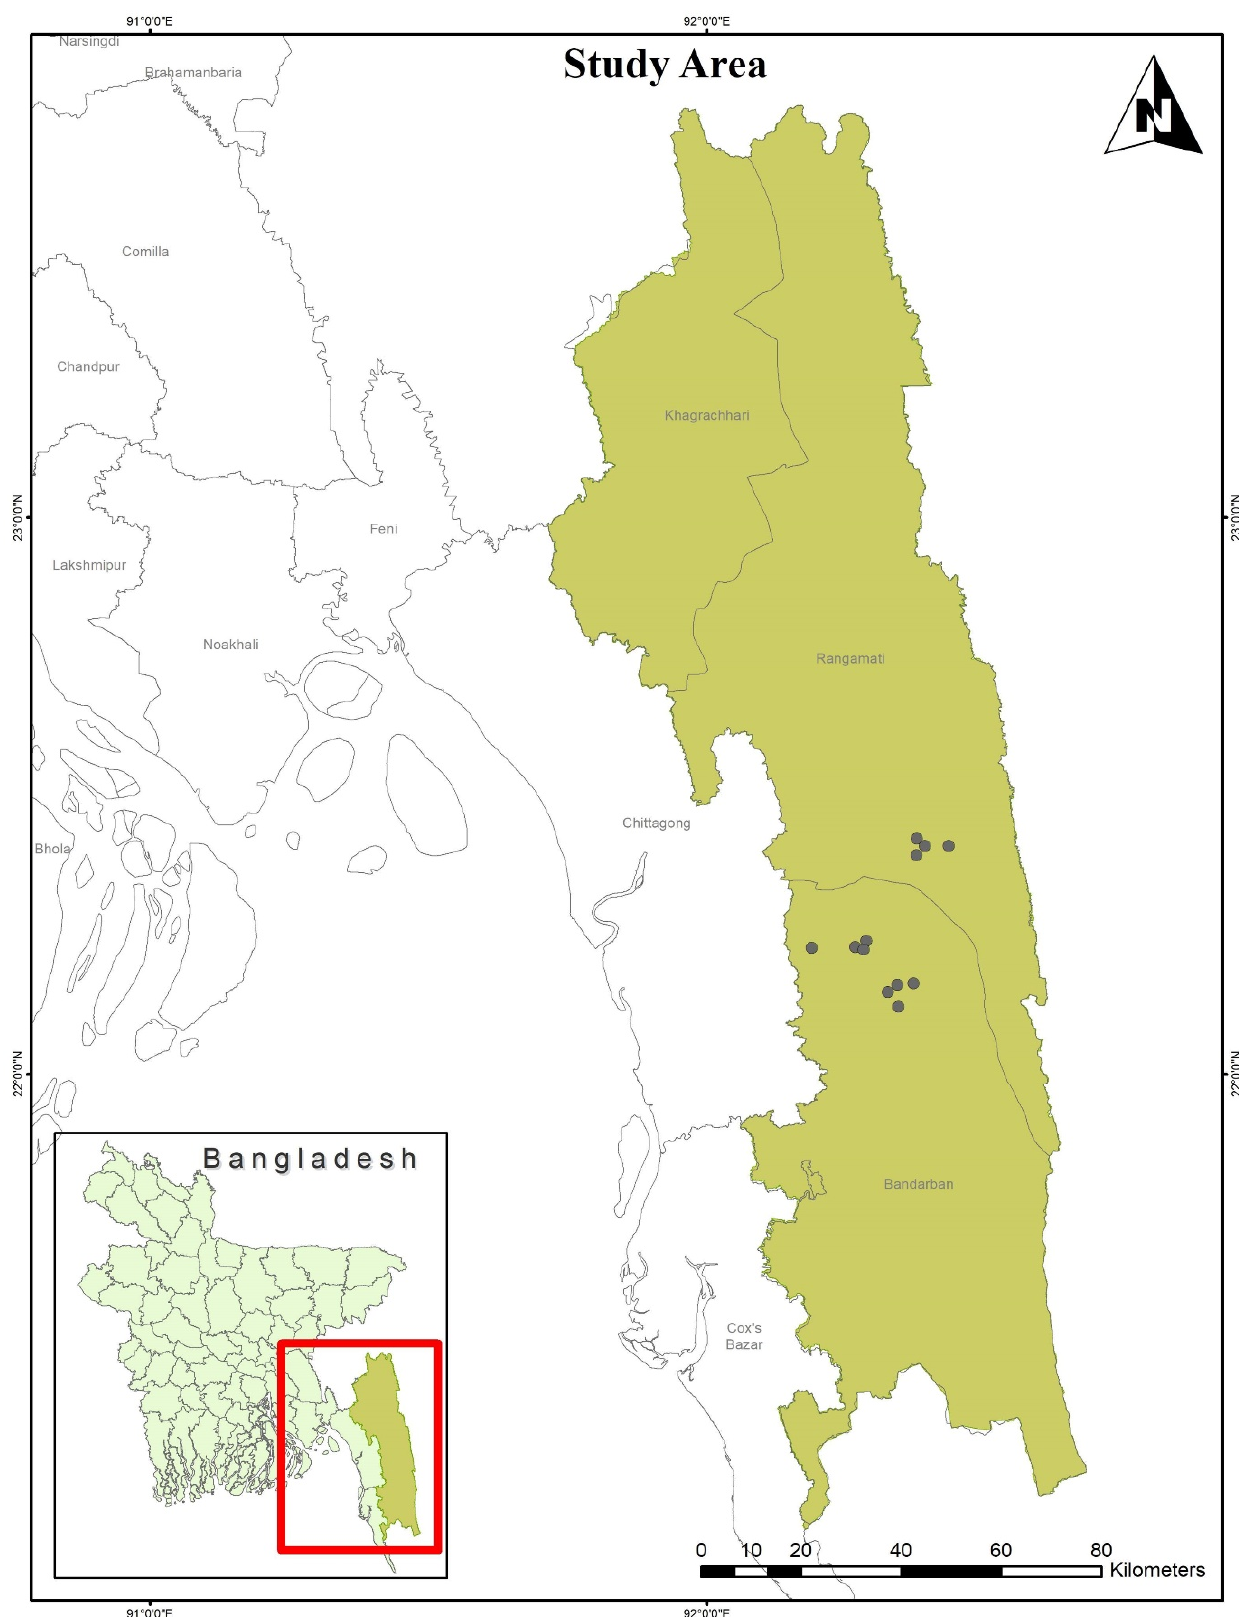
Figure 2. Study location of 8 villages in CHT region (of 12 villages) indicated on the map where focus group meeting was undertaken.